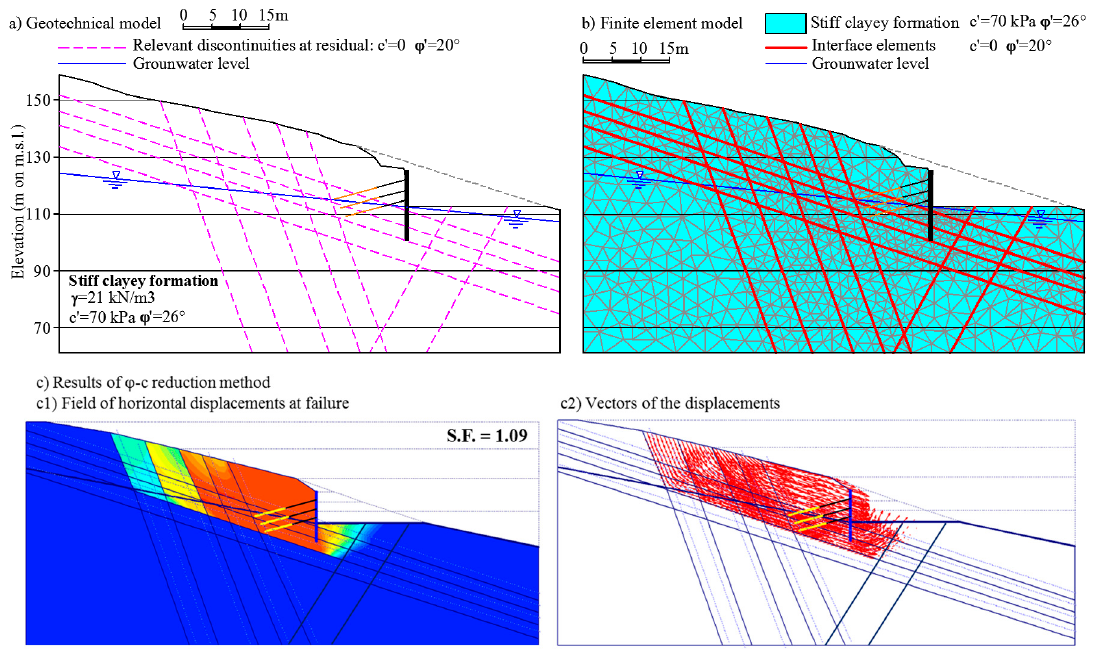
Figure 7. Slope stability analysis at the Baldaia I southern portal: ( a ) Geotechnical model; ( b ) Finite element model; ( c ) Results of the ϕ -c reduction method in terms of horizontal displacements at failure ( c1 ) and vectors of the displacements ( c2 ).